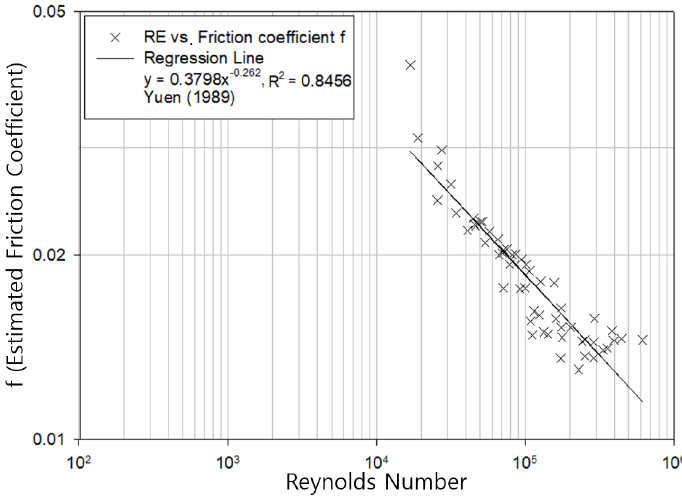
Figure 5. The relationship between f and Re calculated using Yuen’s